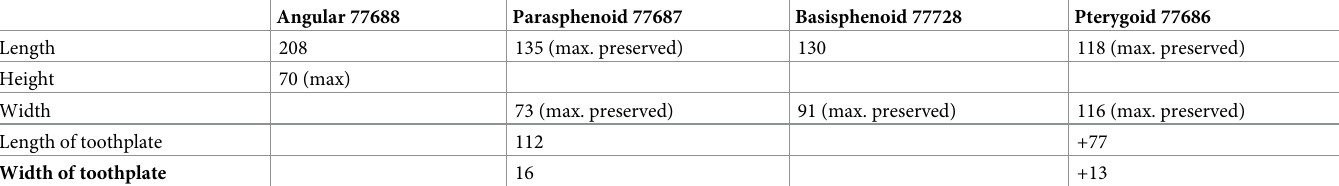
Table 1. Mawsonia sp., bone measurments (in